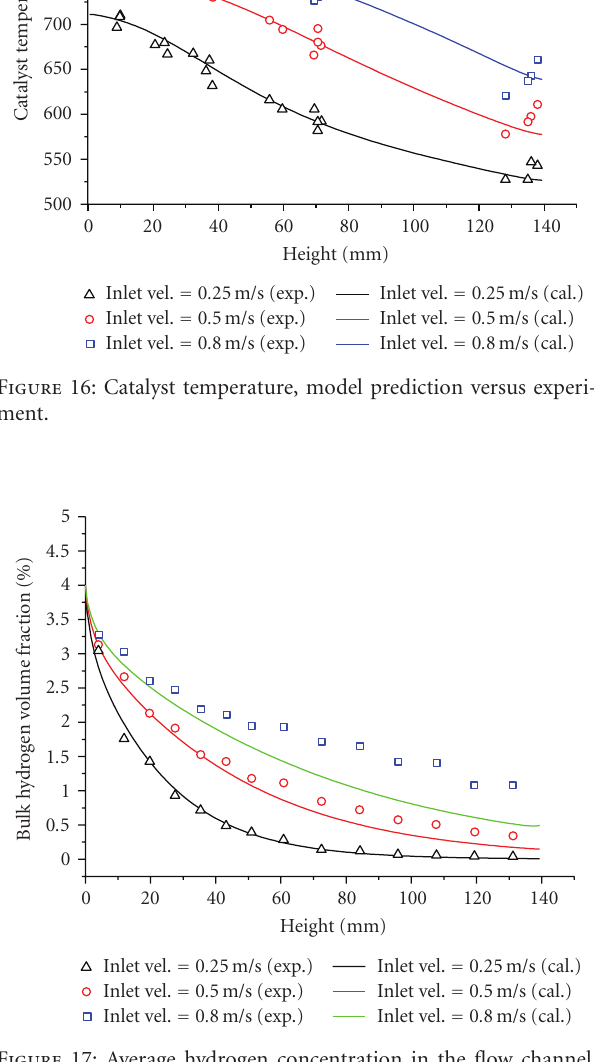
Figure 17: Average hydrogen concentration in the flow channel, model prediction versus